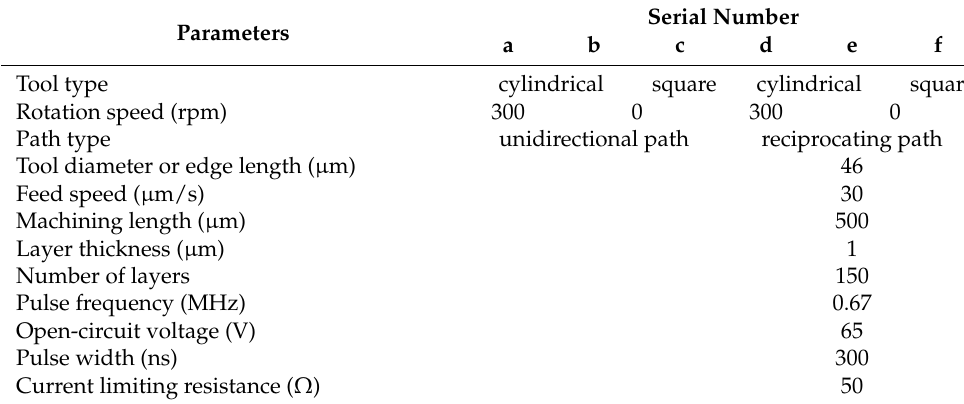
Table 3. Machining parameters for Exp. 1.